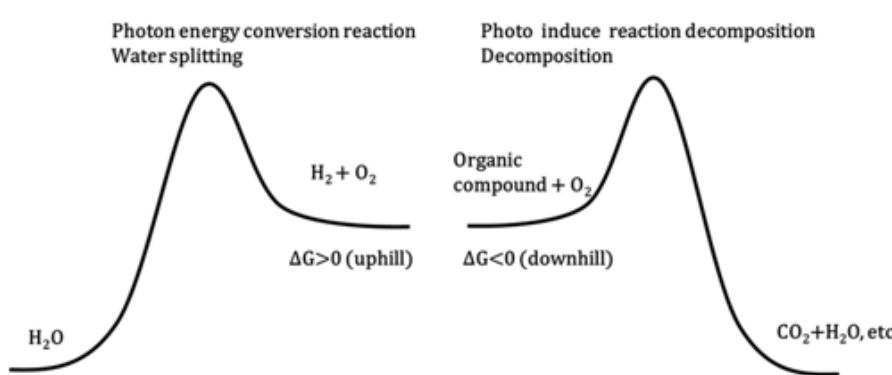
Figure 29. Types of photocatalytic reactions. Reproduced with permission from [130].